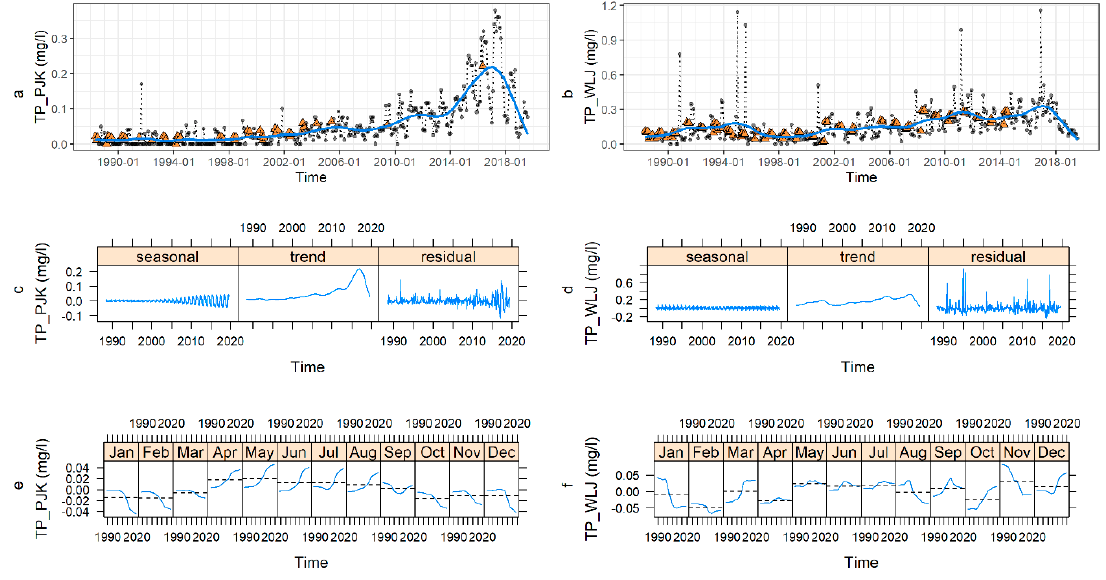
Figure 4. STL results of total phosphorous (TP) concentration. Panels ( a , b ) show the monthly TP concentration (1988–2019) with STL long-term trend line (blue lines) and estimated missing data (triangles) in two sites; panels ( c , d ) illustrate STL long-term (left), seasonal pattern (middle), and residuals (right); panels ( e , f ) show the STL seasonal patterns depicted by month (blue line) with monthly averages (dashed lines).